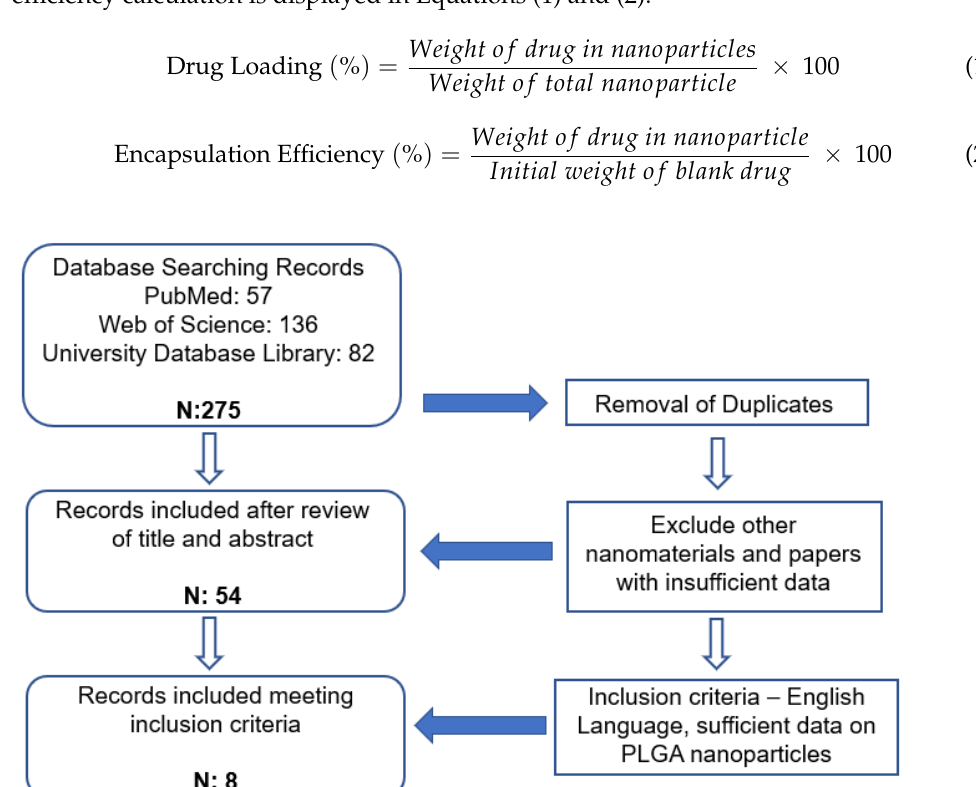
Figure 1. PLGA Nanoparticles Data Extraction Algorithm.